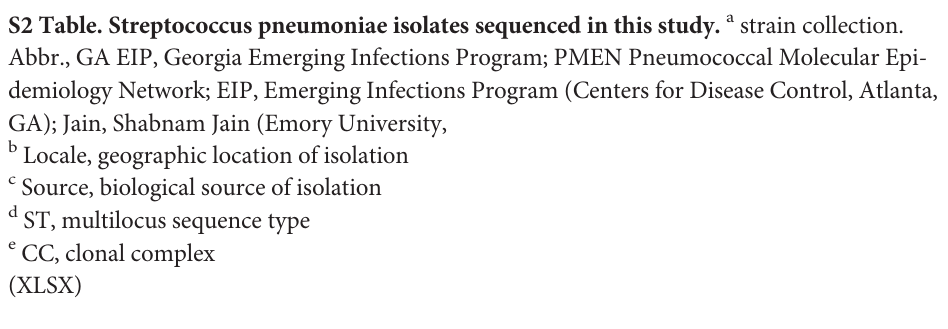
S1 Table. Nucleotide primers used in this study. S2 Table. Streptococcus pneumoniae isolates sequenced in this study. a strain